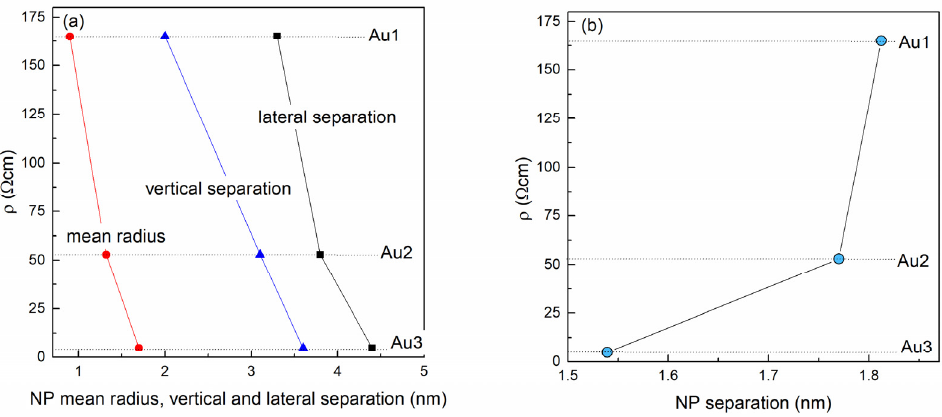
Figure 6. Resistivity as function of the ( a ) Au NP lattice parameters, ( b ) Au NP separation.